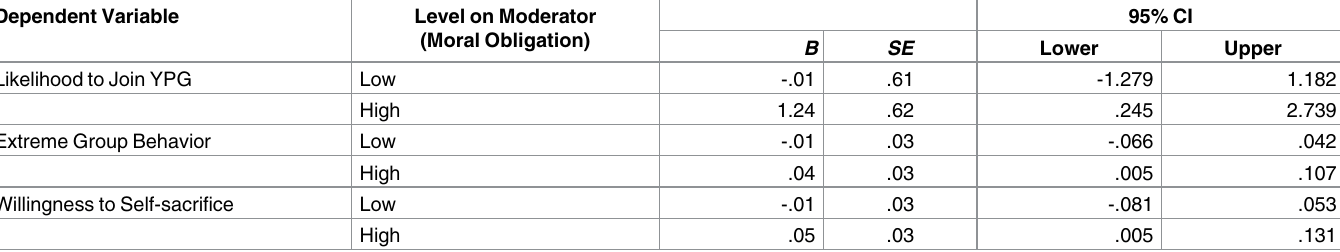
Table 8. Indirect effectsof Leftist orientation on dependent variables mediated by fusion with the out-group at different levels of the moderator perceived moral obligation in Study 4. Dependent Variable Likelihoodto Join